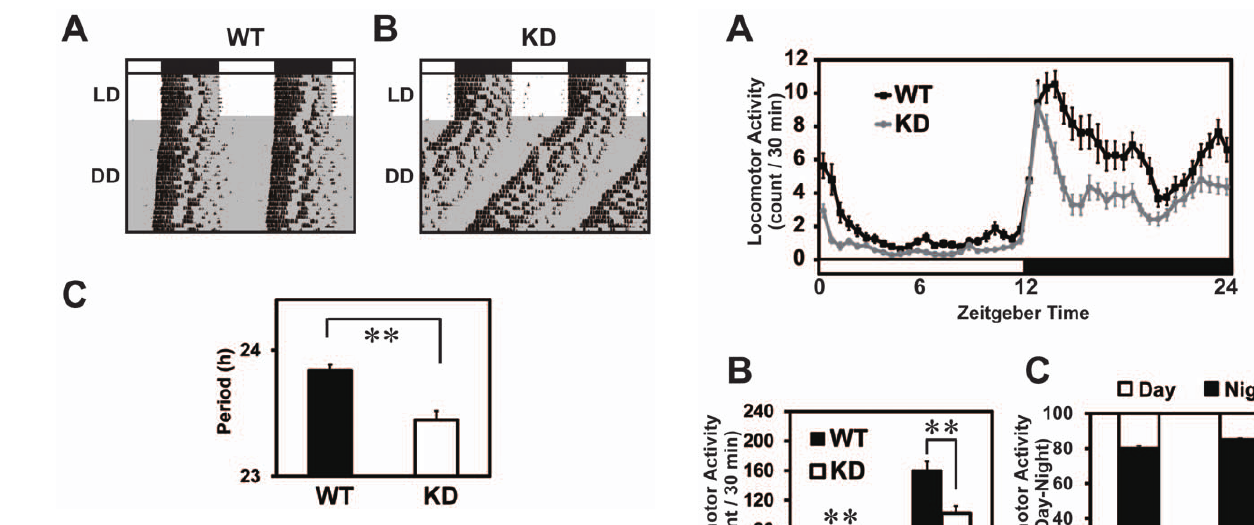
Figure 2. Short free-running period of locomotor activity rhythm in the KD mice. A, B, Locomotor activity rhythms of the WT (A) and KD (B) mice were entrained to 12:12 LD. But in DD, the KD mice exhibited circadian period of locomotor activity shorter than that of WTs. The vertical axis in each graph indicates the day path. Horizontal open and closed bars indicate the light and dark periods, respectively. C, The difference in the circadian period between the KD and WT mice (n=15 each) was statistically significant ** P , 0.01 vs. WT (Student’s t -test).